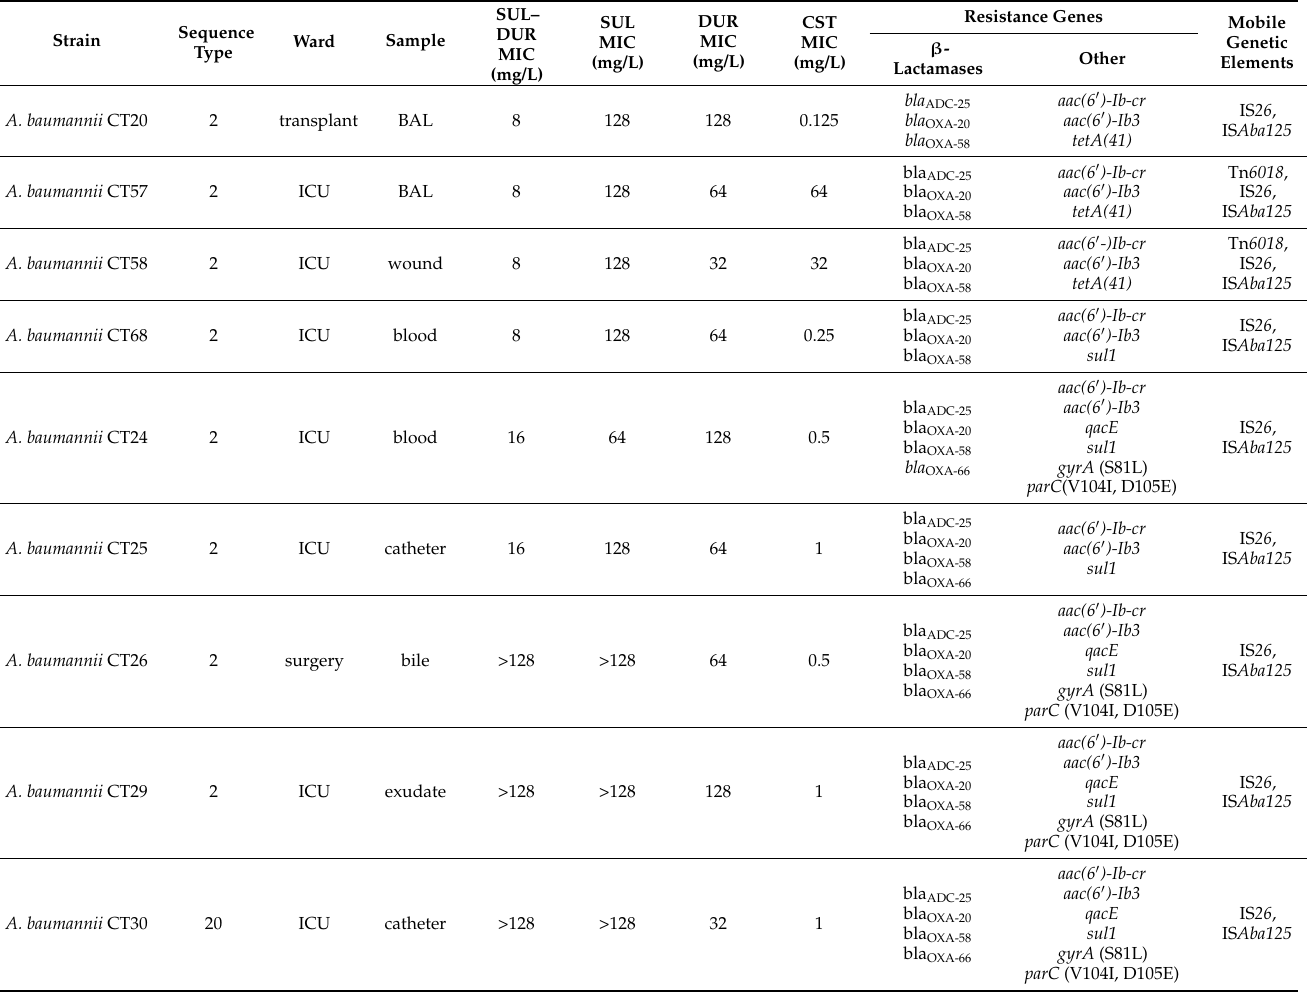
Table 3. Characterization of Sulbactam–Durlobactam-resistant A. baumannii